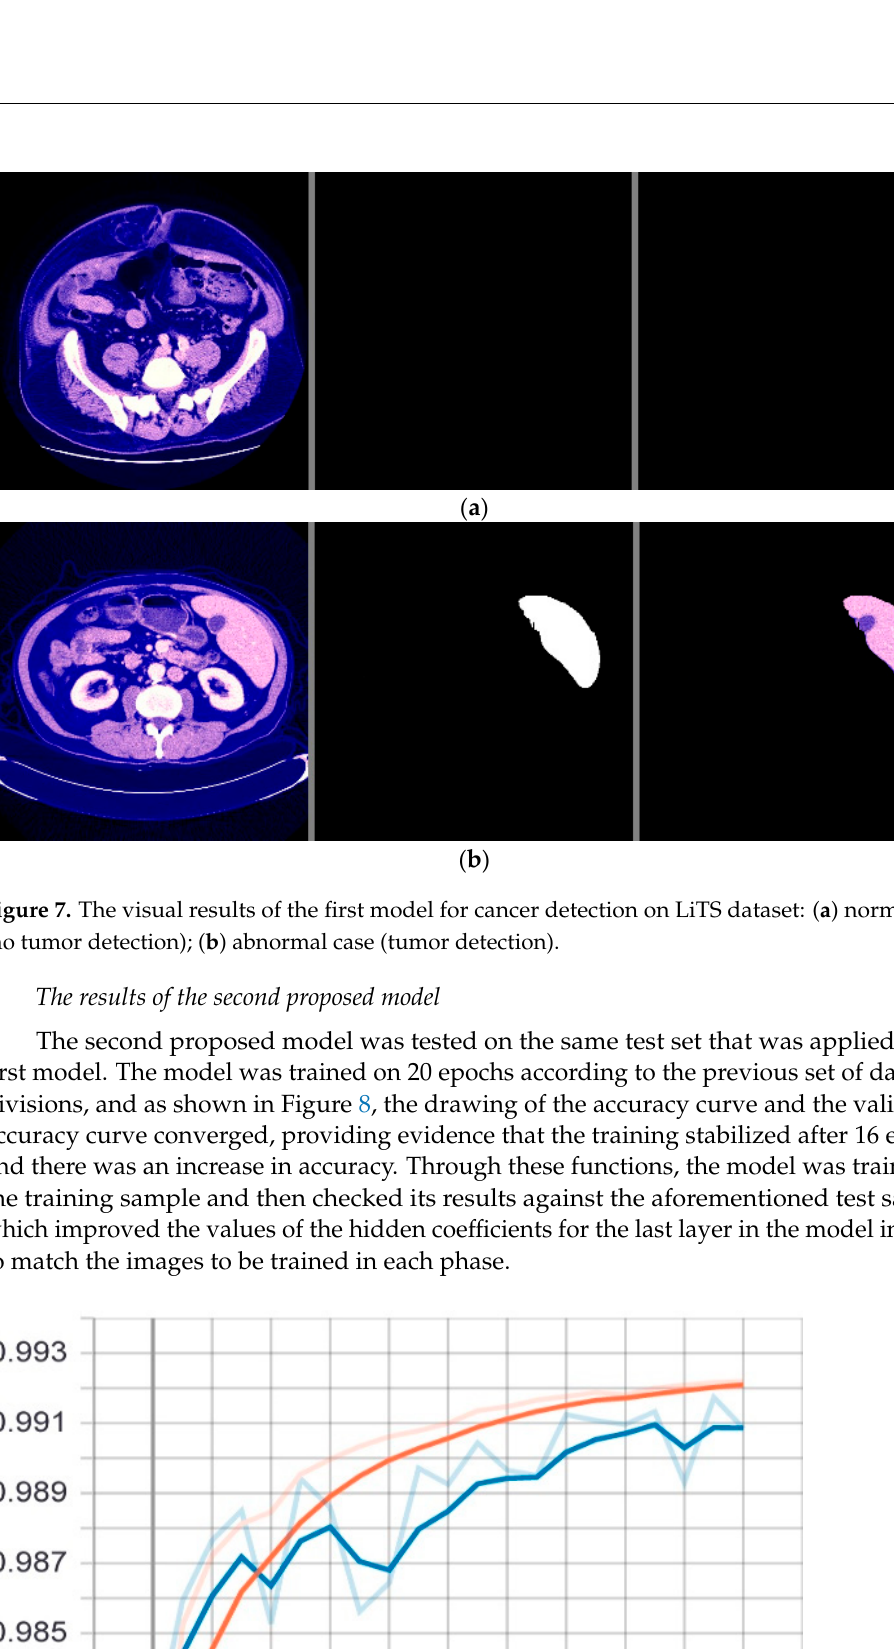
Figure 6. Accuracy (red line) and validation (blue line) loss curves of the first model over 20 epochs.